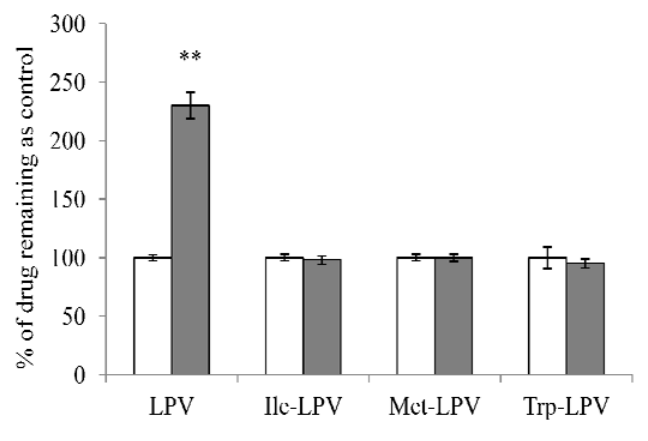
Figure 7. Amount of LPV or prodrug remaining after 15 min incubation in rat liver microsomes (0.3 mg/mL) in the presence (filled bars) and absence (empty bars) of ketoconazole (100 µM). Data points are expressed as mean ± SD, n = 4. Asterisks (**) represent significant difference from the control (in the absence of ketoconazole, p <